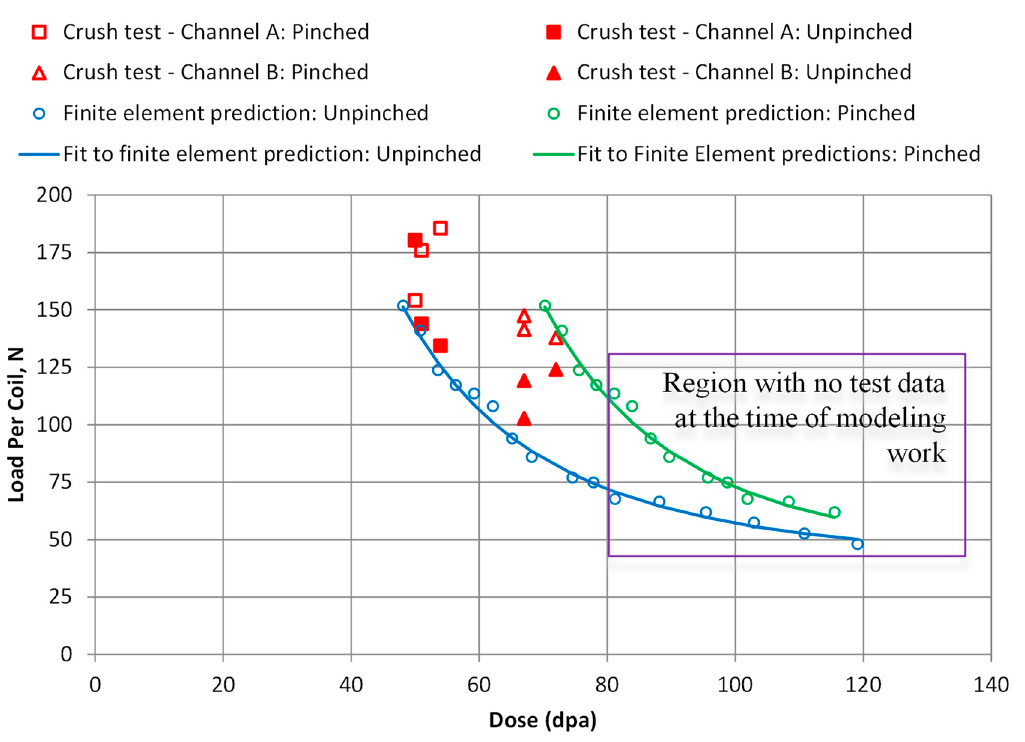
Figure 18. Comparison of finite element predictions for optimized spacers with crush test results from ex-service spacers.